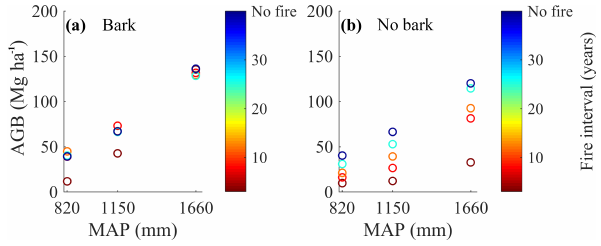
Figure 4. Bark fire survival strategy buffers aboveground woody biomass loss with frequent fire, particularly at high MAP. Model- simulated total aboveground woody carbon (AGB) at different MAP and forced fire regimes for the model with bark (a) and the model with no bark (b) . Simulations were initialized with tropical tree and C 4 grass plant functional types and included a 100-year model spin- up from seedlings. The subsequent 20-year average AGB for each disturbance and precipitation regime is